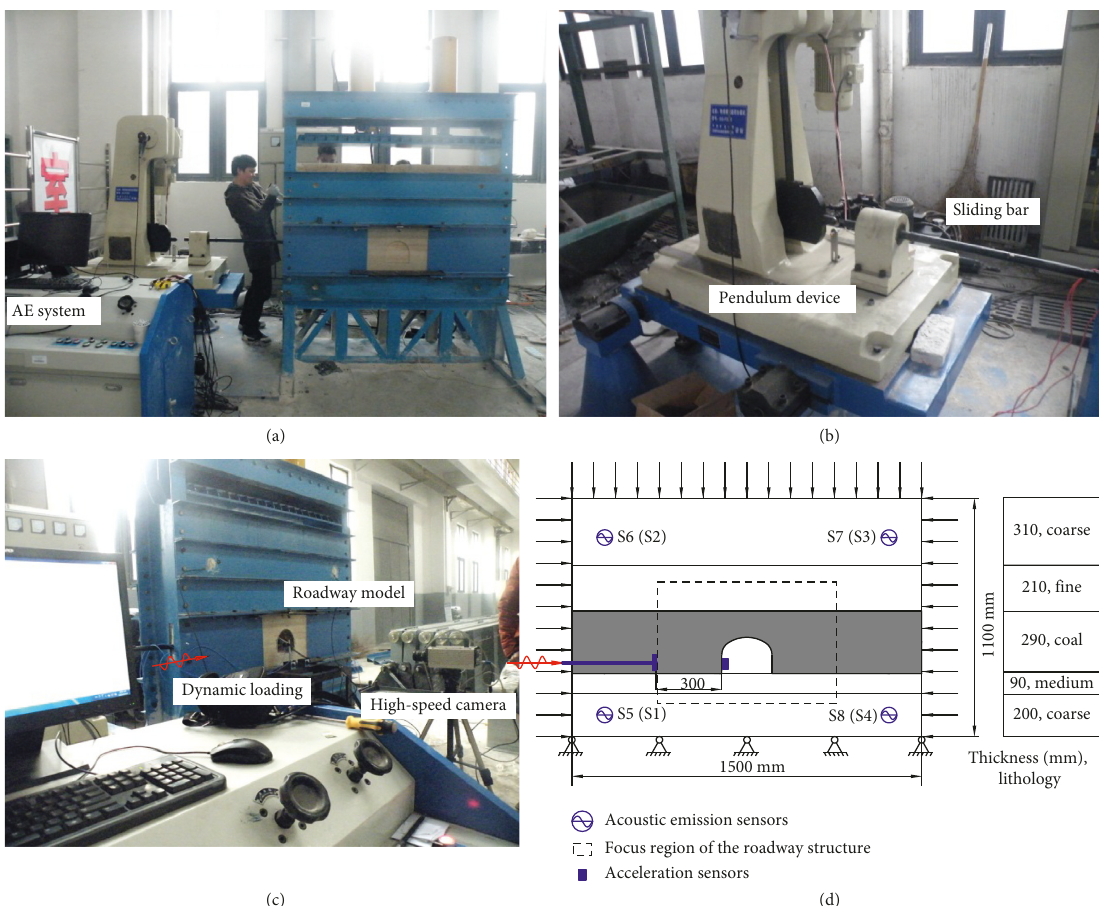
Figure 7: Test facility (a); pendulum device (b); test photograph (c); test schematic diagram